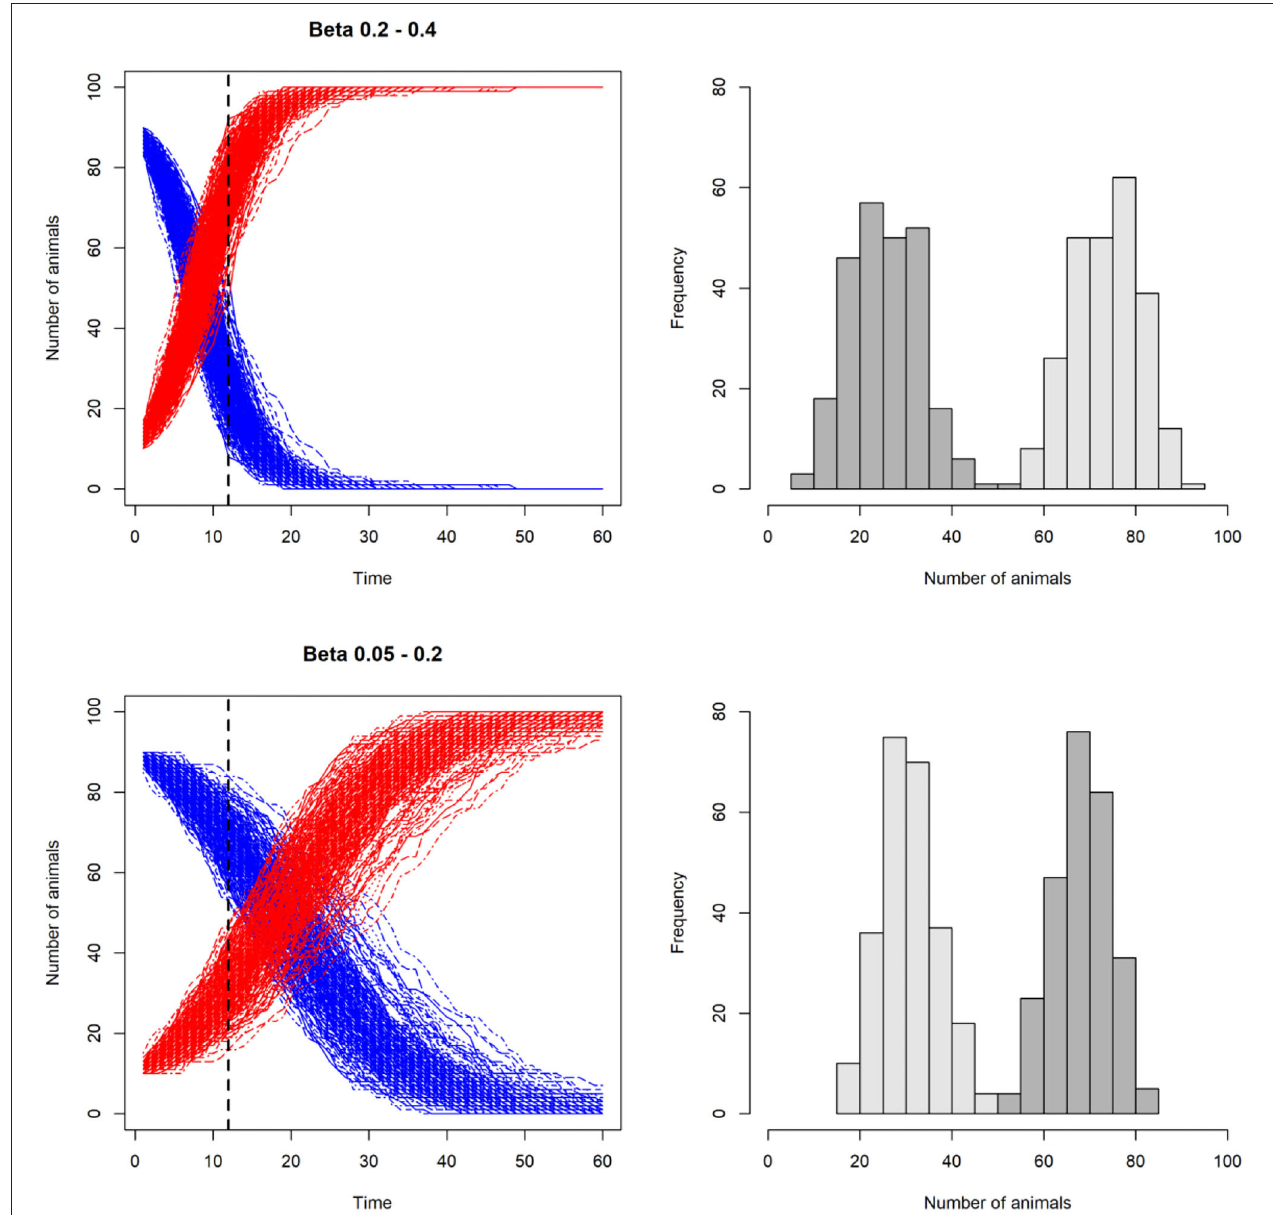
FIGURE 4 | Line plots illustrating the effect of varying the transmission rate, β , on the number of susceptible ( S ) and infected ( I ) animals in a stochastic model with SI disease dynamics. In the two upper plots, β is higher than the two lower plots. This results in higher number of infected than susceptible at day 12 in the upper scenario compared to the lower scenario. In the histograms on the right, the resulting distributions of susceptible (dark gray) and infected (light gray) individuals are shown. Note that β is not kept constant, but varied for each iteration, incorporating uncertainty around this key parameter.